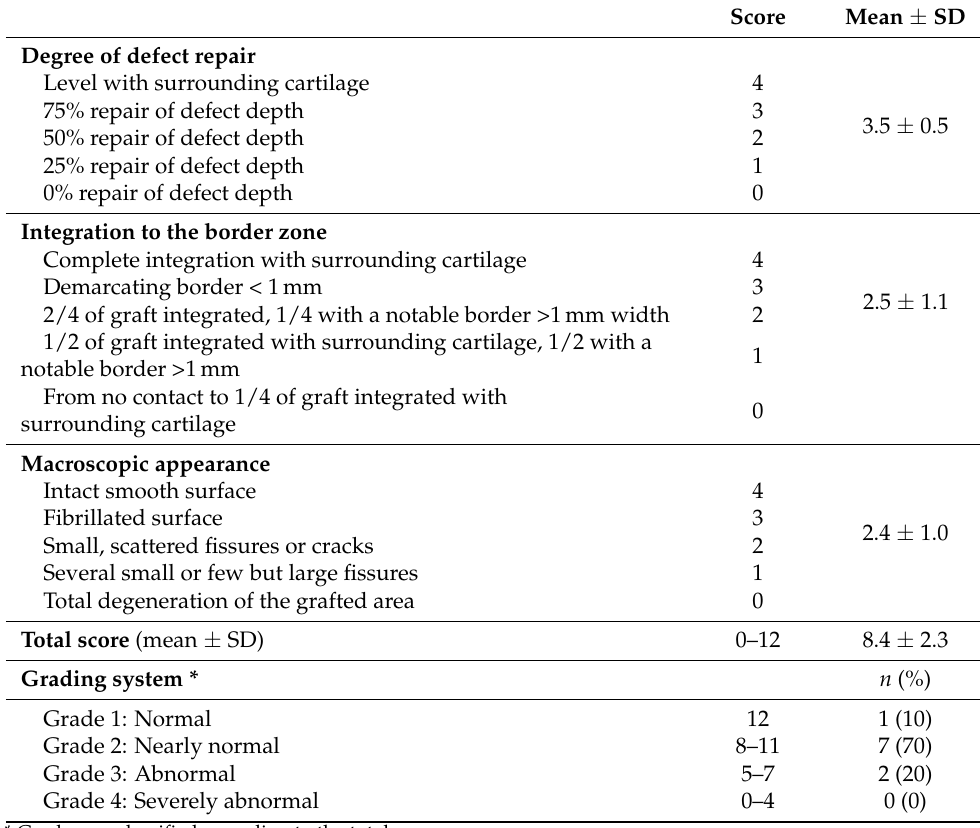
Figure 3. Clinical outcomes after the UCB-MSCs-HA composite implantation combined with HTO. ( A ) Pain on the 100 mm visual analogue scale (VAS) score; ( B ) Western Ontario and McMaster Universities Osteoarthritis Index (WOMAC) score. Table 2. Cartilage repair assessment of second arthroscopic